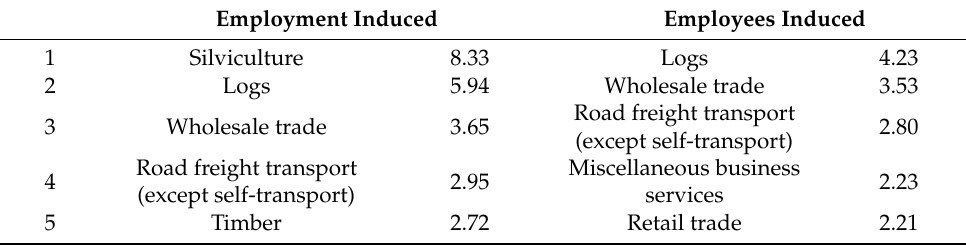
Table 5. Top five sectors with the largest employment impact in the GLT sector (unit: